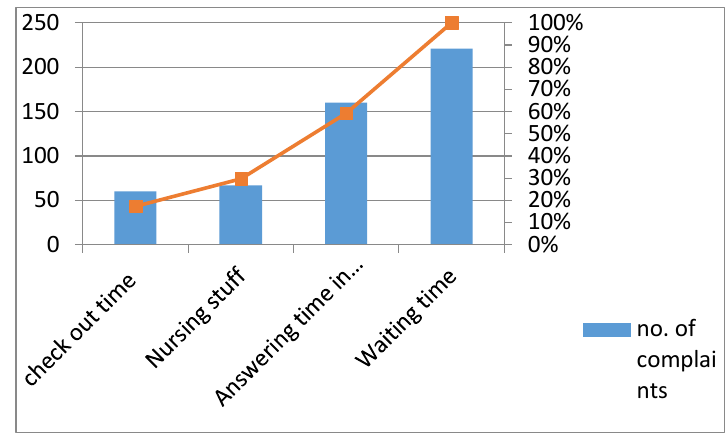
Fig. 6. Pareto chart of the complaint